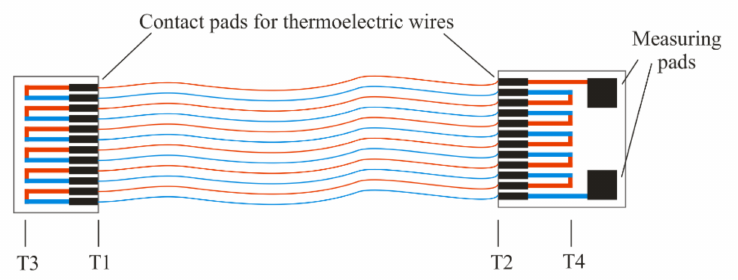
Figure 8. Sensor design: two ceramic substrates with screen-printed thermocouples legs connected by thermoelectric